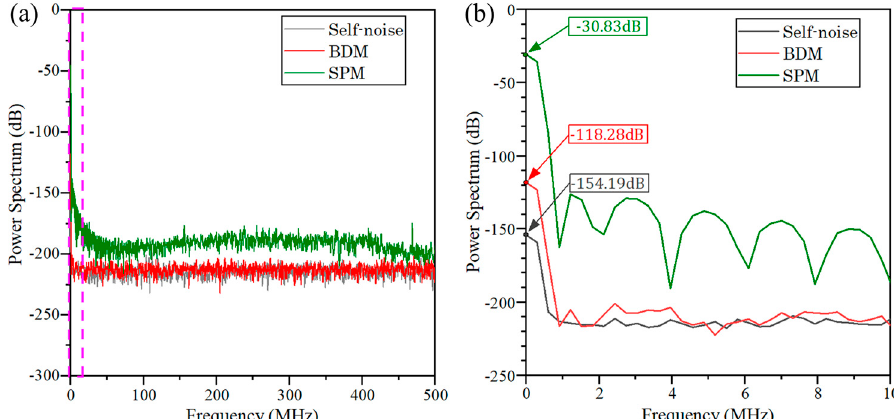
Figure 4. Power spectra of background noise and circuit self-noise measured by the two methods over the frequency band of ( a ) 0~500 MHz and ( b ) 0~10 MHz.